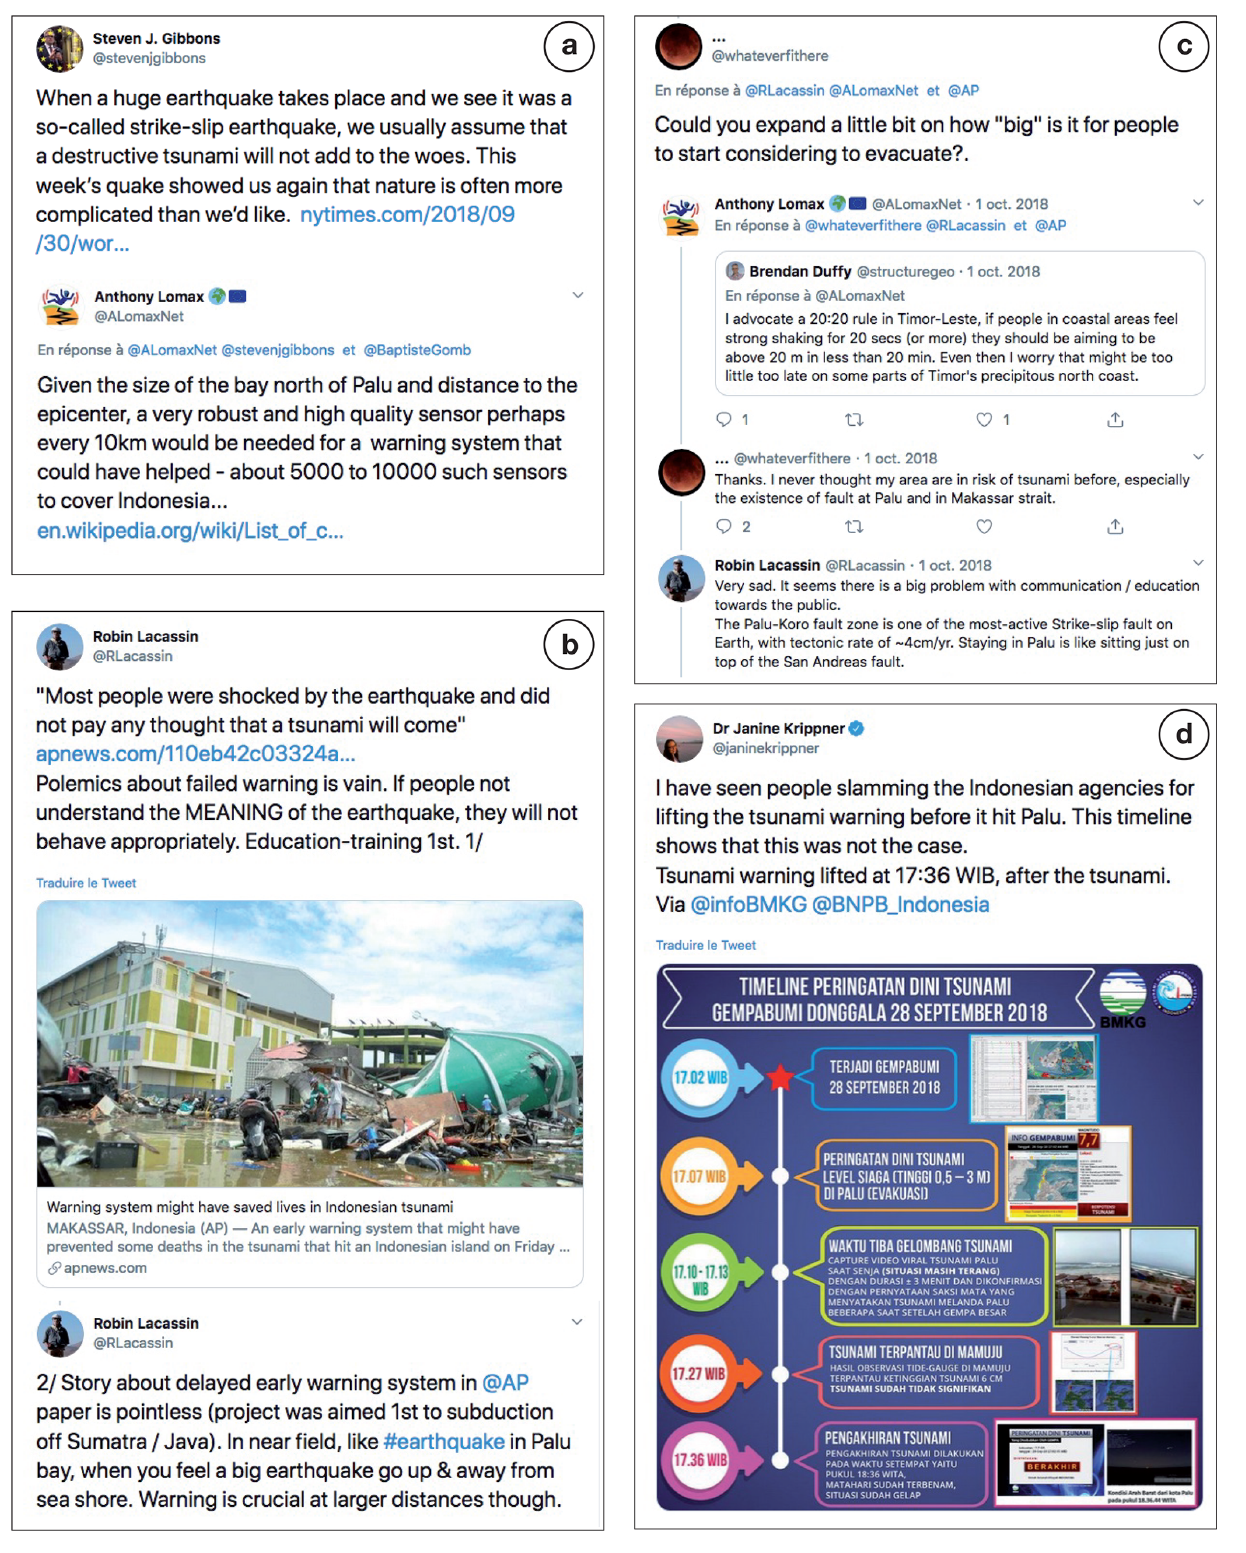
Figure 3. Screenshots of selected tweets about the tsunami warning in the case of Palu. (a, b) Geoscientists quote media articles regarding a possible “failed” tsunami warning and explain that such a warning was extremely difficult in the case of the Palu earthquake (see text for more details). (c) An example of geoscientists engaging in discussion with local people. (d) A geoscientist reports that Indonesian agencies issued an alert in due time and cancelled it only after the tsunami hit